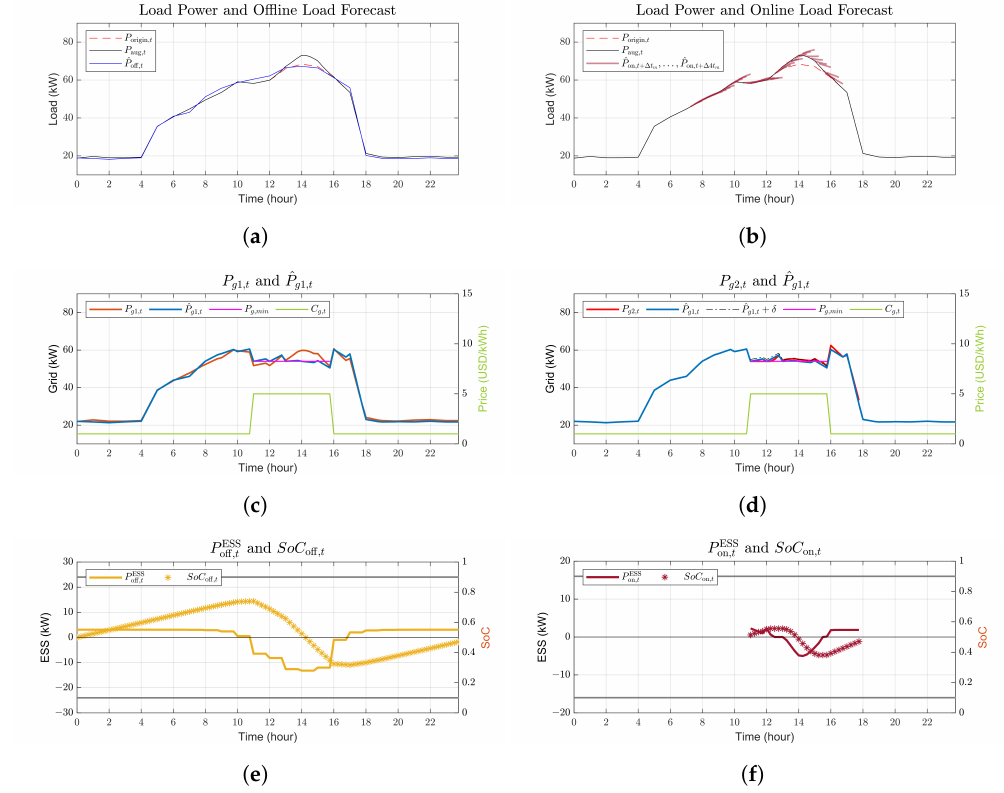
Figure 11. Offline ESS scheduling and online ESS operations with positive synthetic uncertainties. ( a ) Offline load forecast, ( b ) Online load forecast, ( c ) The estimated power ˆ P g 1, t and real power P g 1,